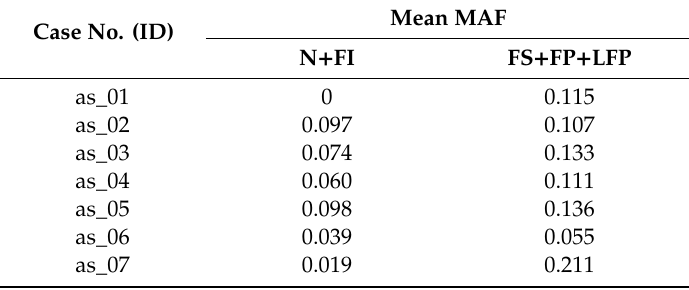
Table 4. Mean minor allele frequencies (MAF) values in una ff ected (N) and atherosclerotic (FI, fatty infiltration; FS, fatty streaks; LFP, lipofibrous plaque; FP, fibrous plaque) aortic tissue samples. Mean Case No. (ID)